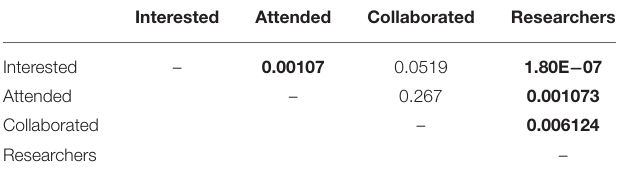
TABLE 2 | Dunn’s test with False Discovery Rate (FDR) correction.